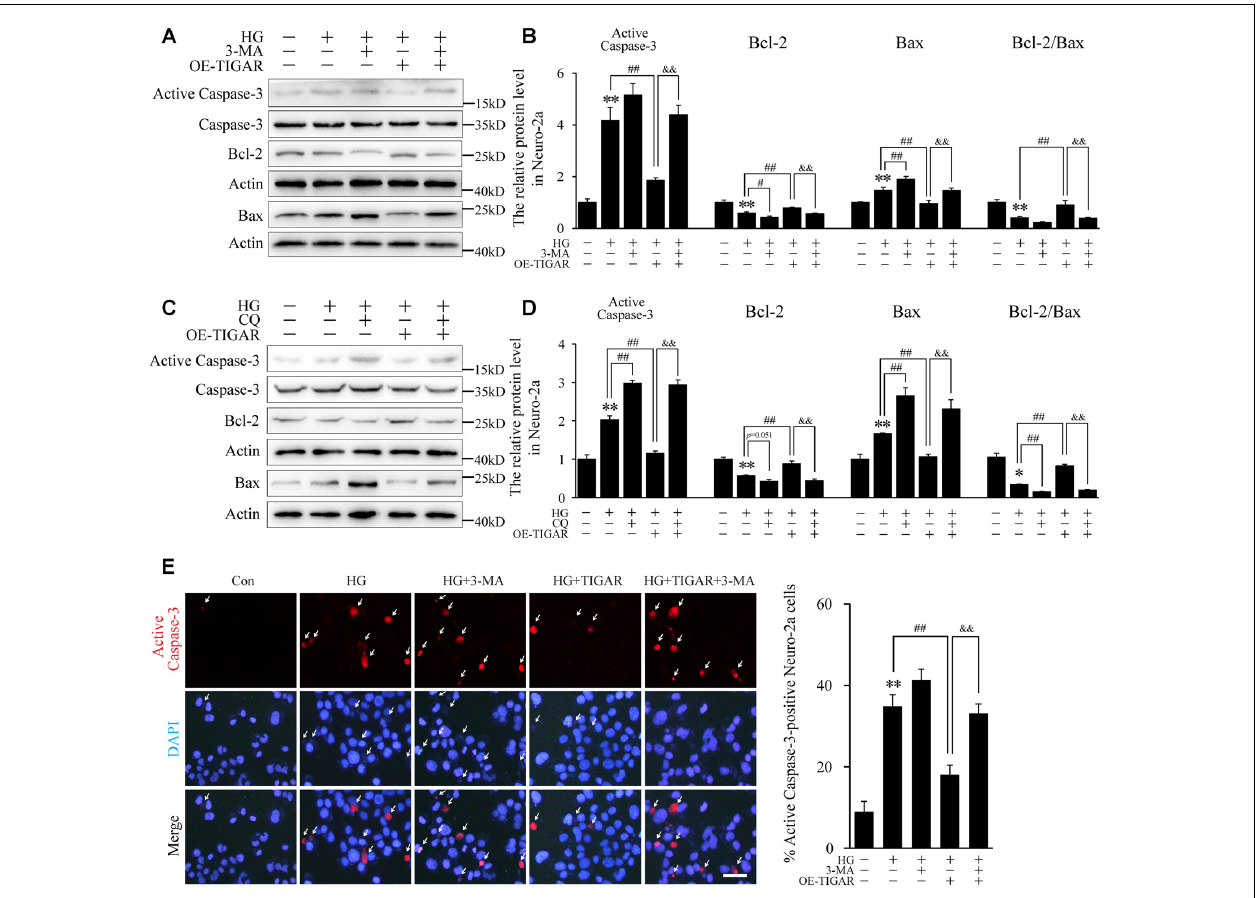
FIGURE 4 | TIGAR reduced high glucose-induced apoptosis through regulating autophagy in Neuro-2a cells. (A–D) Autophagy inhibitors 3-MA and chloroquine diphosphate (CQ) abolished the effect of TIGAR on neuronal apoptosis in high glucose conditions. Western blot analysis of Bcl-2, Bax, active caspase-3 and total Caspase-3 under high glucose condition in each group ( n = 5 per group). (E) Immunofluorescent staining of active Caspase-3 and quantification of active Caspase-3-positive cells in each group ( n = 9 per group). Scale bar = 40 µ m. ∗ p < 0.05, ∗∗ p < 0.01 vs. the control group, # p < 0.05, ## p < 0.01 vs. the HG group, && p < 0.01 vs. the HG+TIGAR group, two-way